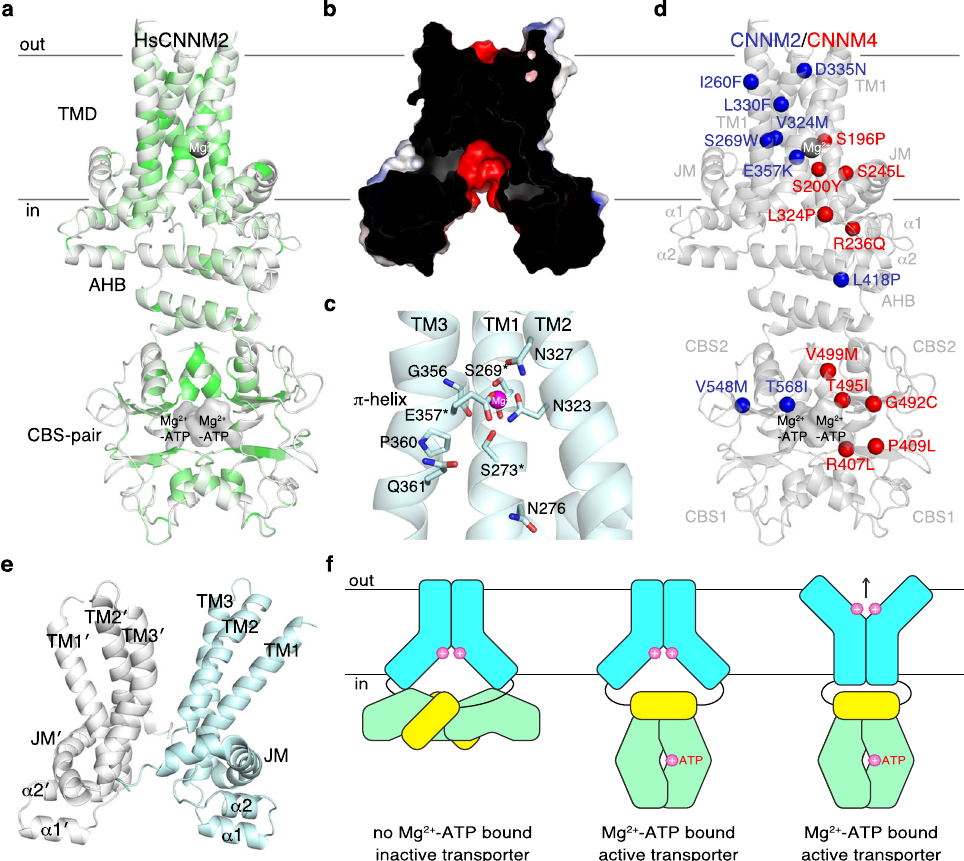
Fig. 7 Molecular modeling. a Homology model of human CNNM2 (HsCNNM2) color-coded according to identity to CNNM/CorB proteins shown in Supplementary Fig. 2. Conservation is highest around the Mg 2 + binding site, negatively charged cavity, and the CBS-pair dimerization interface. b Electrostatic surface potential analysis (±5 kT e − 1 ) shows conservation of negatively charged cavity in HsCNNM2 in cross-sectional view. c Conservation of the polar residues in the Mg 2 + binding site and π -helical turn of HsCNNM2. Asterisk denotes disease-causing mutations. d Mutations in CNNM2 and CNNM4 responsible for hypomagnesemia and Jalili syndrome cluster around the core of the TMD and nucleotide-binding site. For clarity, mutations are only shown on one chain. e Outward-facing conformation generated by MD simulations. f Proposed model of MtCorB transport and regulation. Loss of Mg 2 + -ATP binding, CBS-TMD contact inactivates TMD in the inward-facing conformation. Upon Mg 2 + -ATP binding, CBS-TMD contact is alleviated, thereby activating and allowing TMD to mediate Mg 2 +